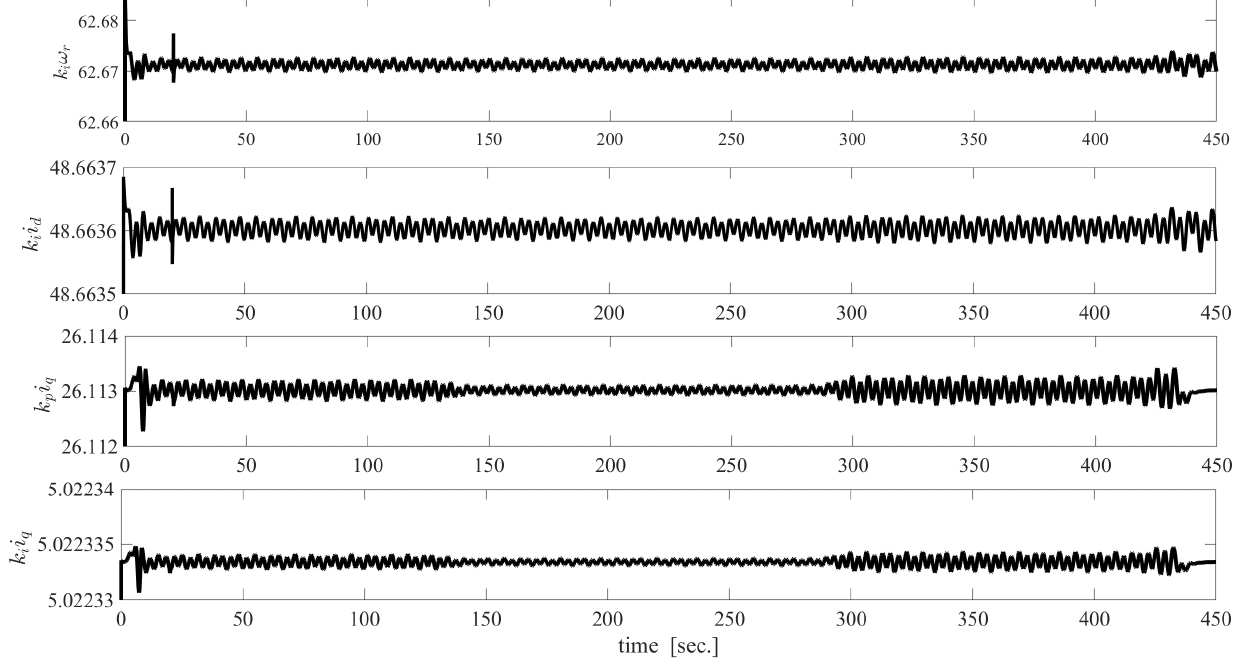
Figure 13. Adaptive control parameters are computed by the B-spline neural network.